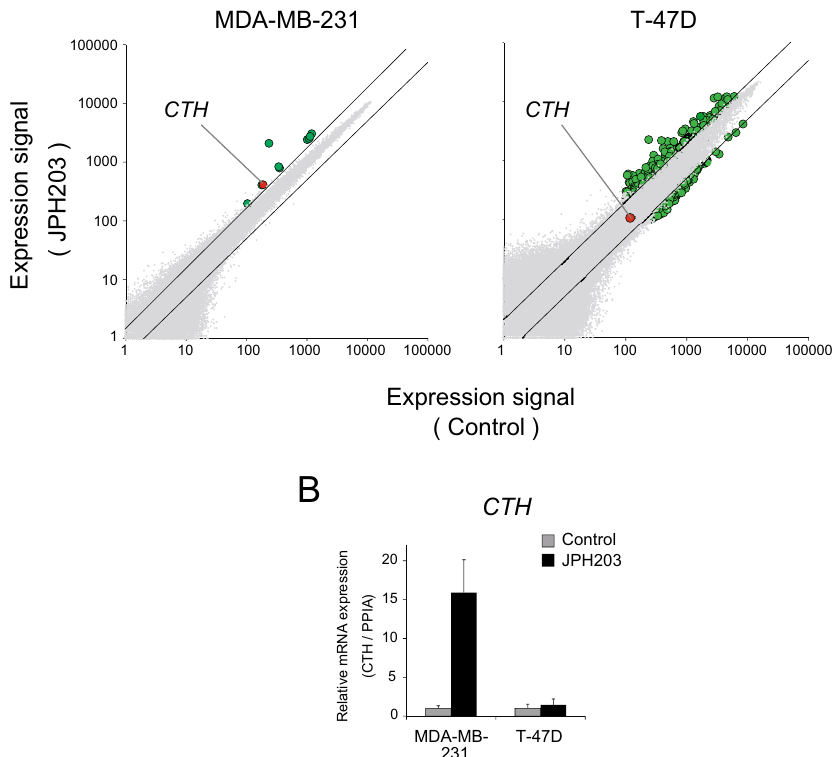
Figure 2. Transcriptome analysis of MDA-MB-231 and T-47D cells in the presence/absence of JPH203. ( A ) DNA microarray was performed in the presence of 100 μM JPH203 for 24 h in MDA-MB-231 and T-47D cells. A gene was regarded as differentially expressed if the signal intensity of JPH203 treated condition/signal intensity in control condition was ≤ twofold or ≥ twofold (green dots, CTH was designated by red dots). ( B ) CTH mRNA expression in the presence/absence of 100 μM JPH203 for 12 h in MDA-MB-231 and T-47D cells by qPCR.